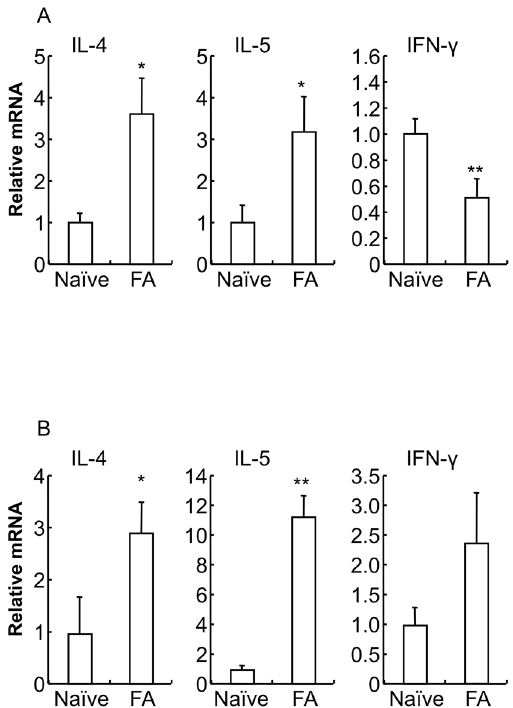
Figure 2. Induction of predominant Th2 cytokine responses in food allergy mice. IL-4, IL-5 and IFN- c cytokine mRNA expression in the spleen ( A ) and proximal colon ( B ) from naı¨ve mice and FA mice were measured by real-time PCR. Relative mRNA levels of cytokines were normalized to GAPDH expression. Data are expressed as means 6 SE. * P , 0.05, ** P , 0.01 vs. naı¨ve mice ( n =4–8 mice per group).